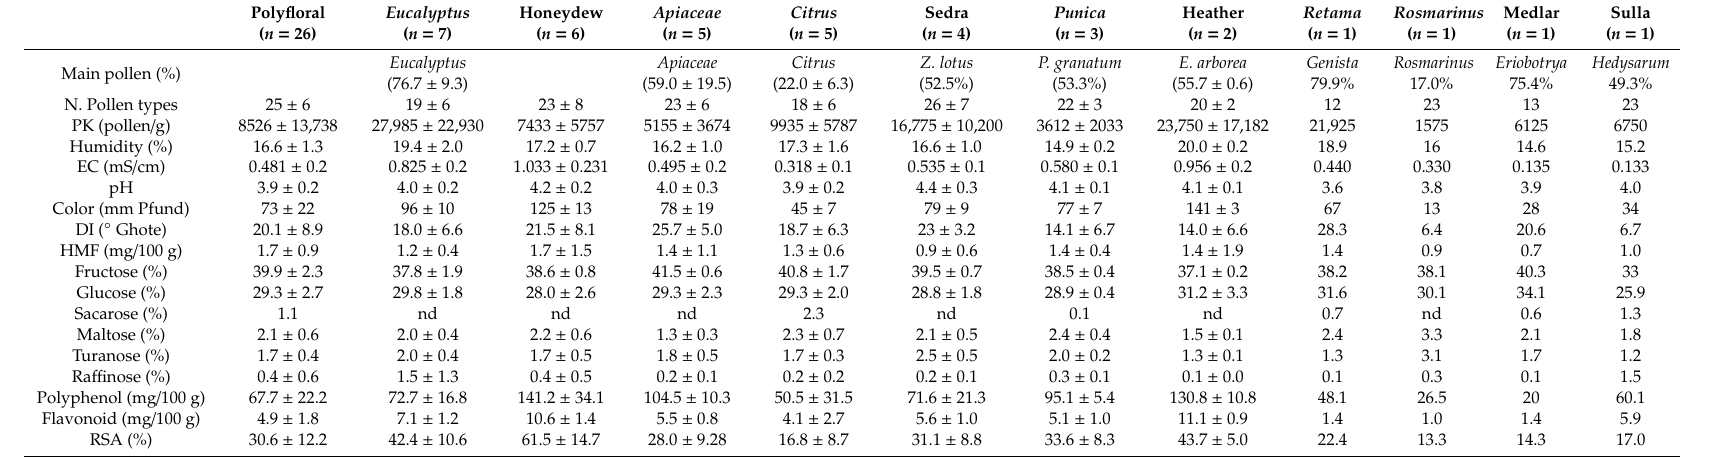
Table 3. Characteristics of the di ff erent honey types. Values are expressed as mean and standard